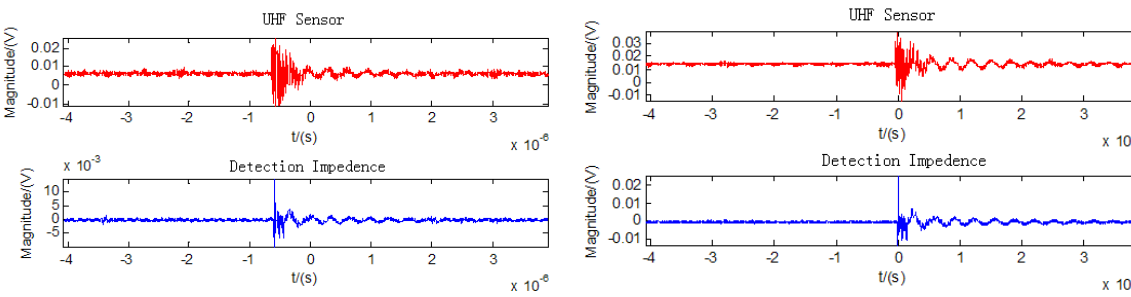
Figure 9. The measured waveforms of different kinds of discharges.